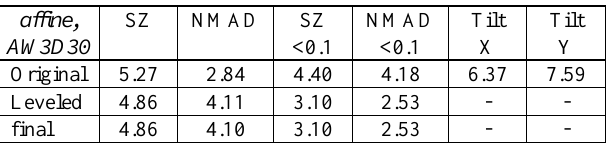
Table 10: Accuracy figures and DSM-tilt over full range [m], ZY3 against AW3D30 DSM; orientation by bias correction with affine transformation; <0.1 = for slope below